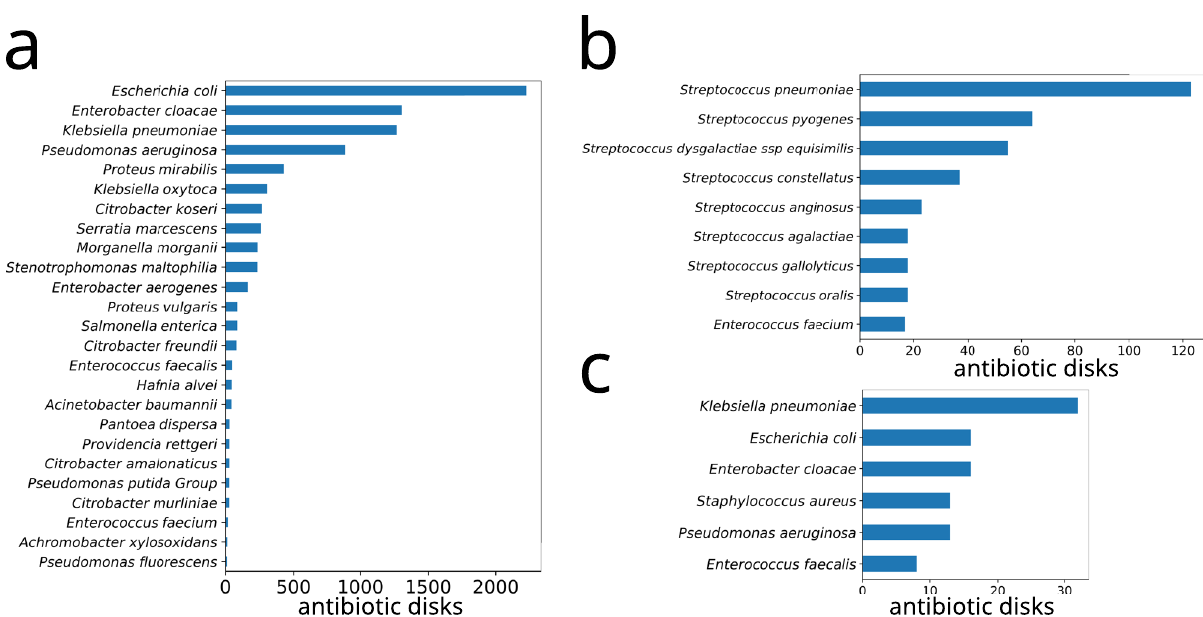
Fig. 5 Distribution of species in the AST groups used in this study. a Dataset A1. b Dataset A2. c Dataset